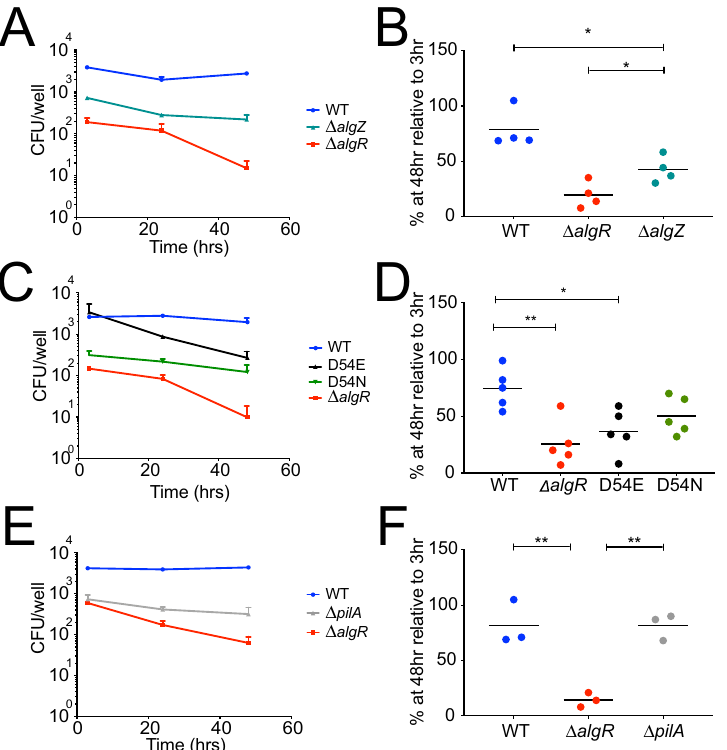
Fig 3. Phosphorylation-independent and -dependent roles of AlgR in intracellular survival and host cell invasion. Cells were infected at MOI = 10 with the kinase deficient strain Δ algZ , the phosphomimetic D54E or non- phosphorylatable D54N single point algR mutants, or the pilus deficient strain Δ pilA . (A, C, E) At indicated time points, cells were lysed and the intracellular bacterial load was determined. (B, D, F) Percent of recovered bacteria at 48 hpi relative to 3 hpi. Each data point represents an independent experiment. � p < 0.05 �� p < 0.005 based on one-way ANOVA.